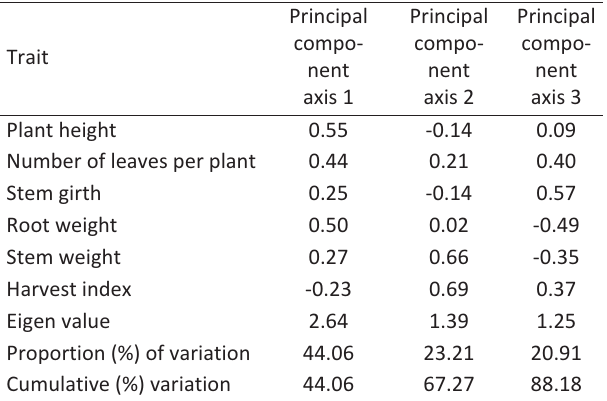
Table 3 ­ Loadings from principal component axes of the com­ post used in this study